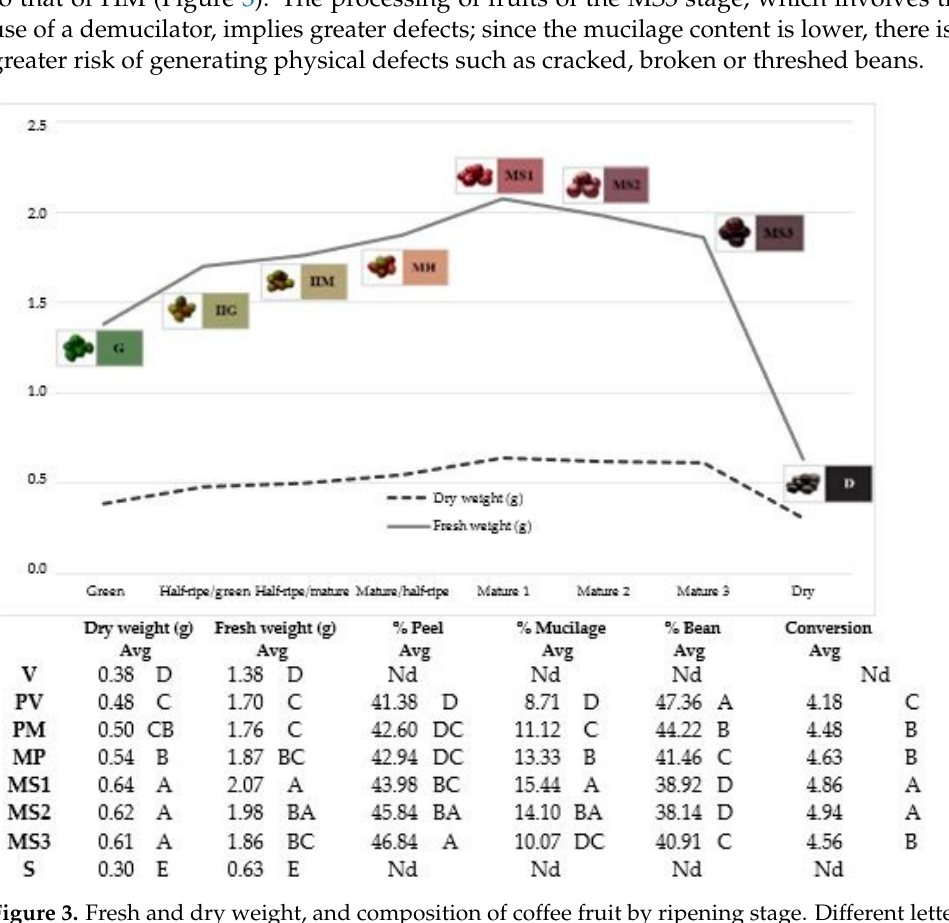
Figure 3. Fresh and dry weight, and composition of coffee fruit by ripening stage. Different letters indicate a difference between means according to Duncan’s test at 5%.